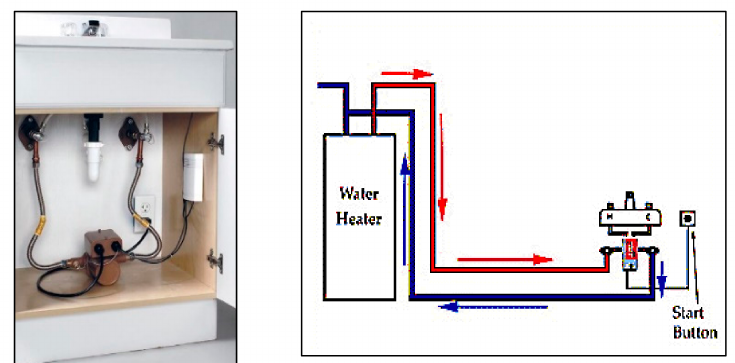
Figure 3. On–demand